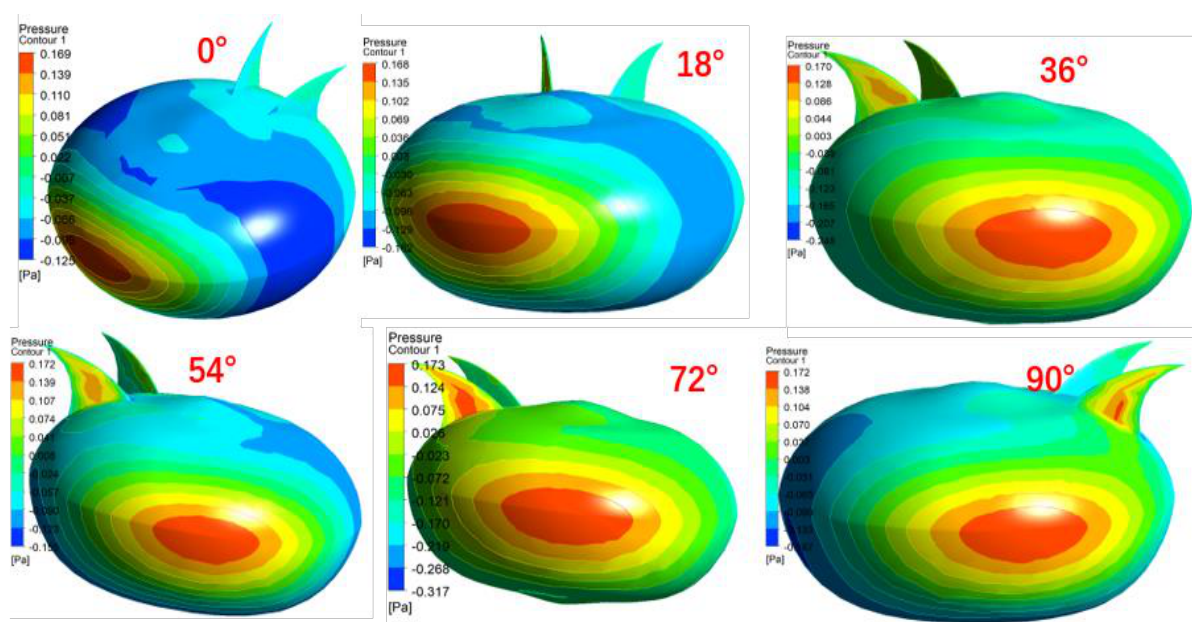
Figure 4. Velocity contour of the shell with fins at different angles. As the angle is rotated, the velocity around the fins increases and reaches a maximum at 72 degrees.